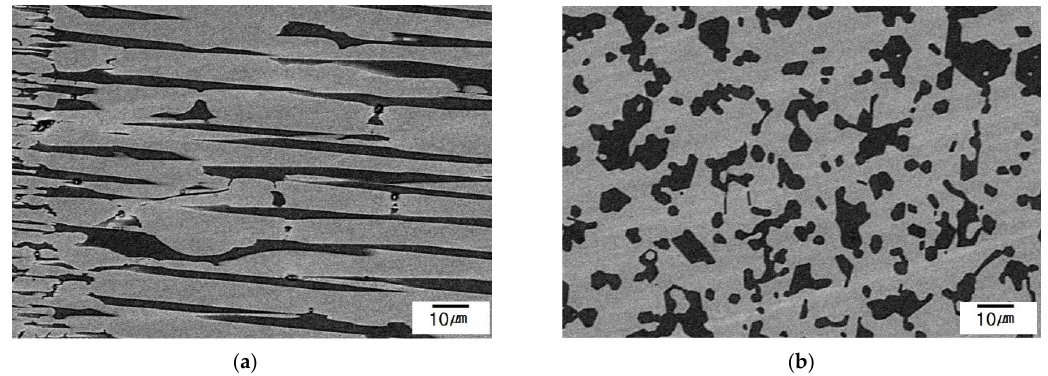
Figure 5. Typical micrographs of DS specimen solidified at 1 µ m/s. ( a ) parallel to the solidification direction; ( b ) normal to the solidification direction.